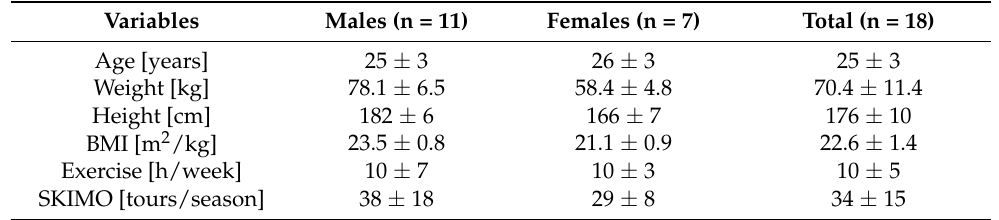
Table 1. Demographic and anthropometric characteristics of the study group. Values are means ±